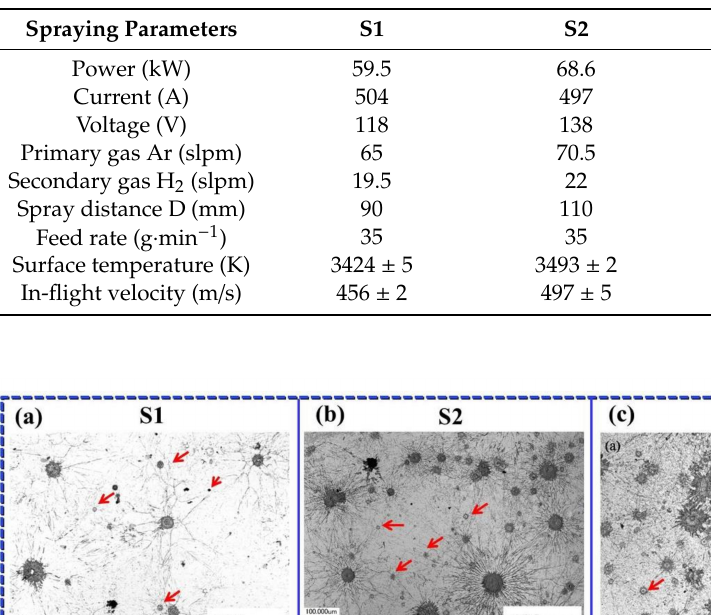
Table 1. Spray parameters for 8 wt % YSZ splat and coating.